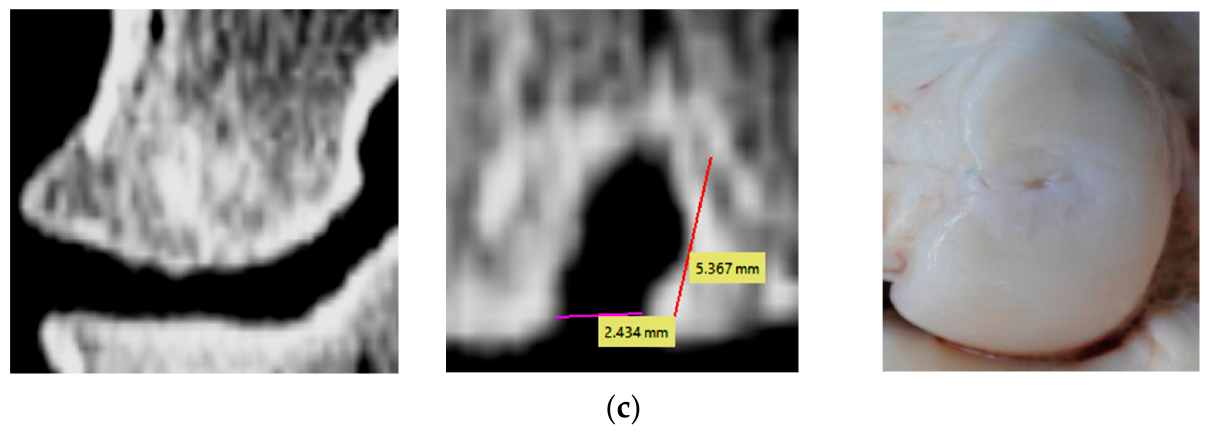
Figure 4. Comparative post-operative CT images of surgical treated areas (coronal and sagittal views): ( a ) Case 1 (just porous collagen); ( b ) Case 2 (Collagen + BMC); ( c ) Case 3 (Collagen + ASC).